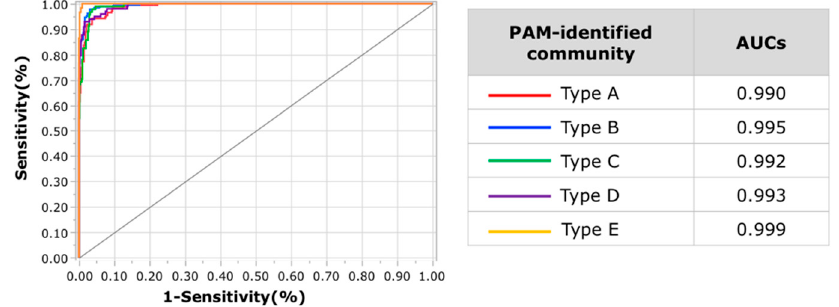
Figure 5. ROC curves and AUC values from the support vector machine model. Assessment of ROC curves evaluating the ability to predict each gut microbiota community type using an SVM classification model. Each curve represents the sensitivity and specificity to distinguish subjects into each community type. The area under the curve (AUC) of the ROC curve for each community type is displayed in the table on the right.